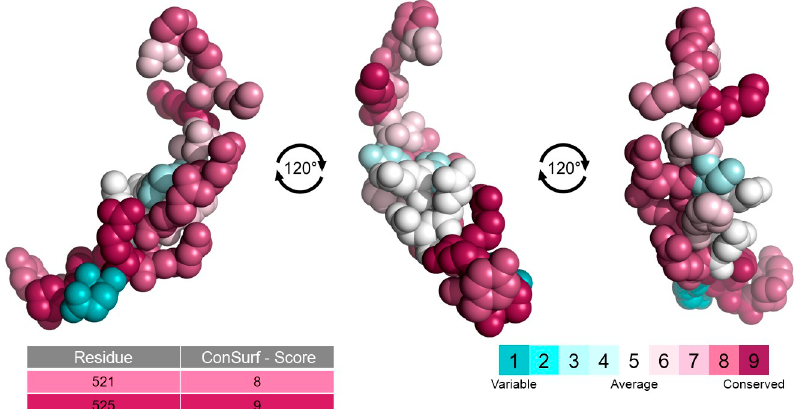
Fig 3. Evolutionary conservation analysis. Amino acid conservation analysis of wild-type FUS protein fragment (residue 507 to 526) represented in a space-filling model and colored according to conservation scores. Conservation scores of the residues where R521C, R521H, and P525L mutations occur are highlighted in the table. CONSURF color scheme representing conservation levels. Cyan represents more variable positions, while bordeaux represents more conserved